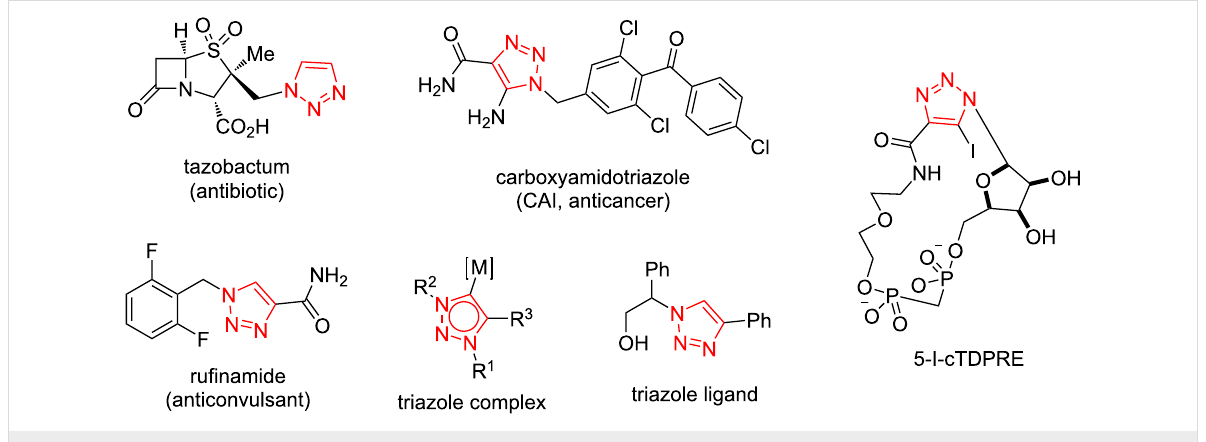
Figure 1: Some significant triazole derivatives